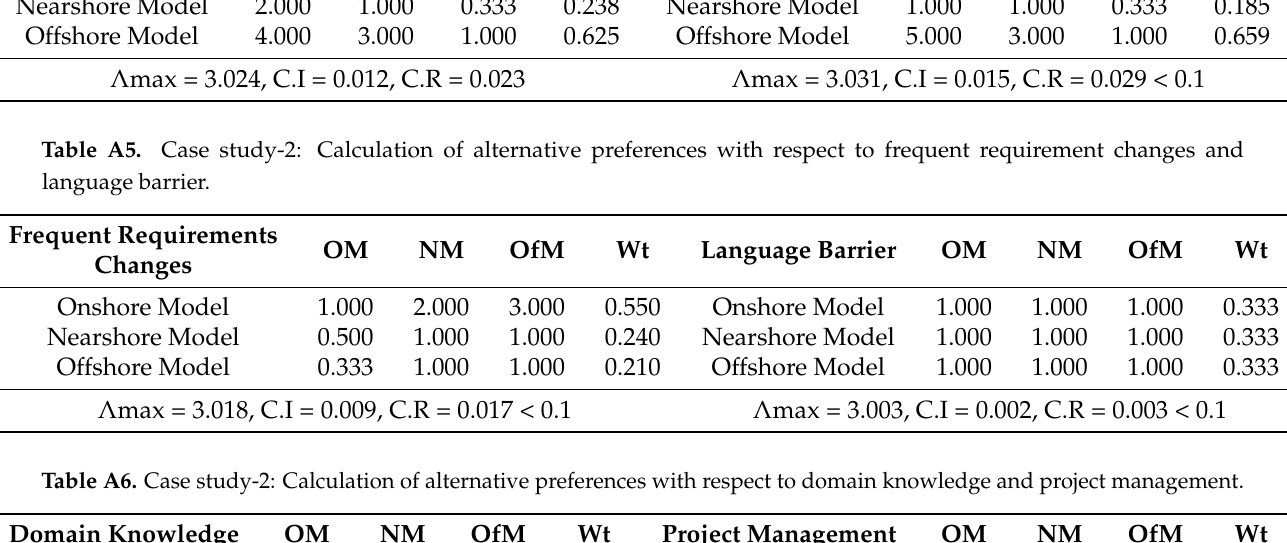
Table A6. Case study-2: Calculation of alternative preferences with respect to domain knowledge and project management. Domain Knowledge Onshore Model